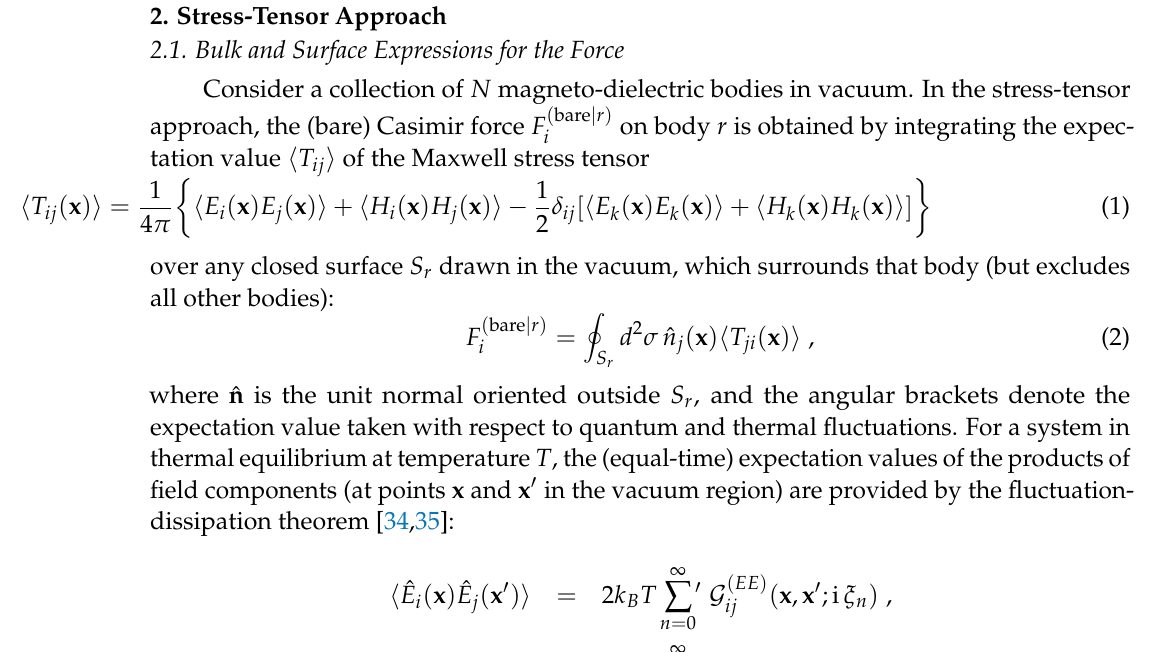
Figure 1. Configuration of bodies: ( a ) general shapes and positions that can be studied with the approaches presented in this work, ( b ) non-penetrating configurations that can be studied within the scattering